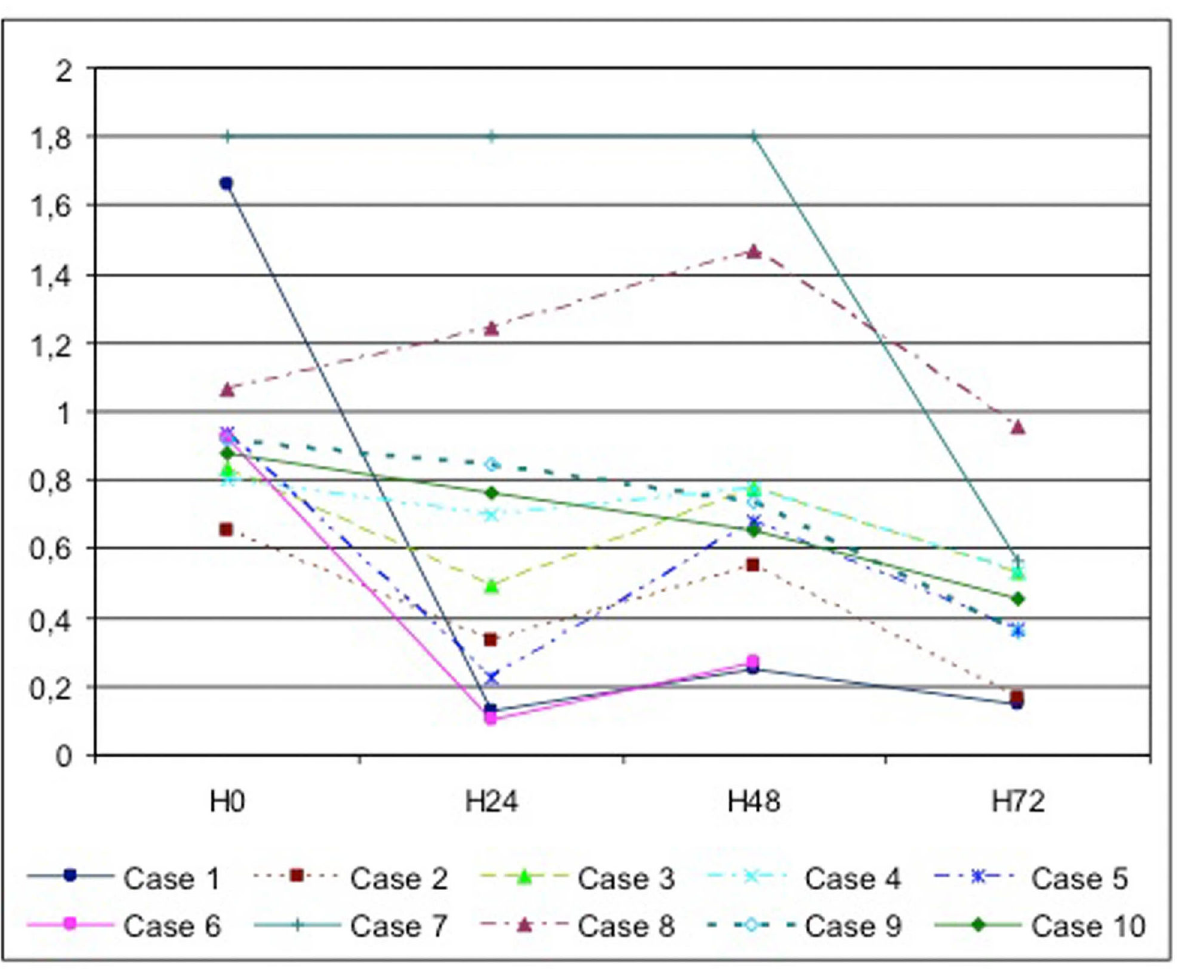
Figure 2. Viability of human pancreas tissue slices cultured ex-vivo for up to 3 days by a MTT test at each step of the procedures at baseline, H24, H48 and H72. All data are given as the means of at least three slices. doi: